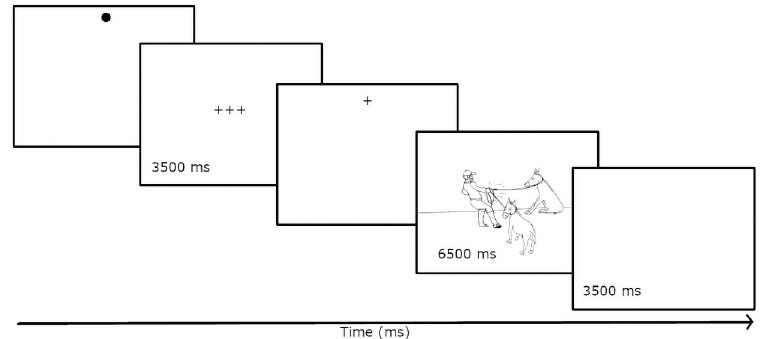
Fig 3. Presentation sequence of stimuli in trials without the concurrent memorization